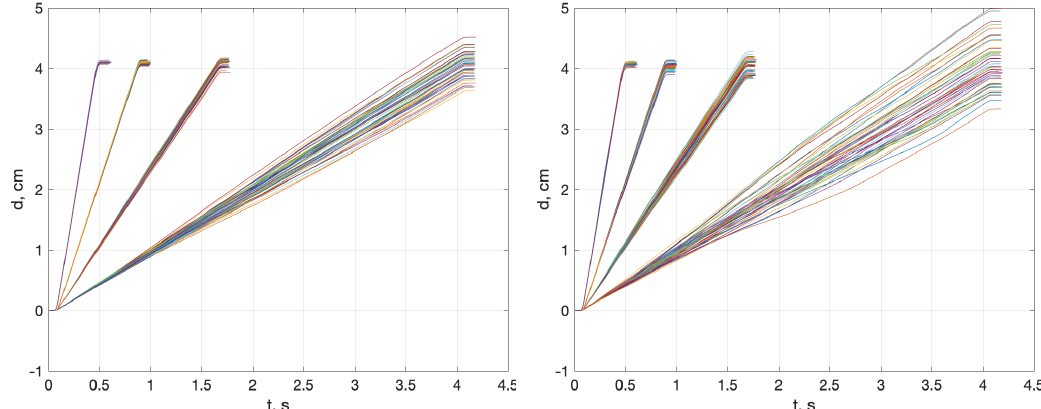
Figure 6. Estimated short range distance profiles for sensors Accel.LS ( left ) and Accel.WR ( right ), for the four integration times and the MSI method. For short integration times (0.5 and 0.9 s), a better mean error of Accel.WR masks its greater variance in the final RMS value. Example at 0.9 s: Accel.WR: rms = 0.05 cm, mean = 0.02 cm, var = 0.05 cm; Accel.LS: rms = 0.09 cm, mean = 0.09 cm, var = 0.02 cm.